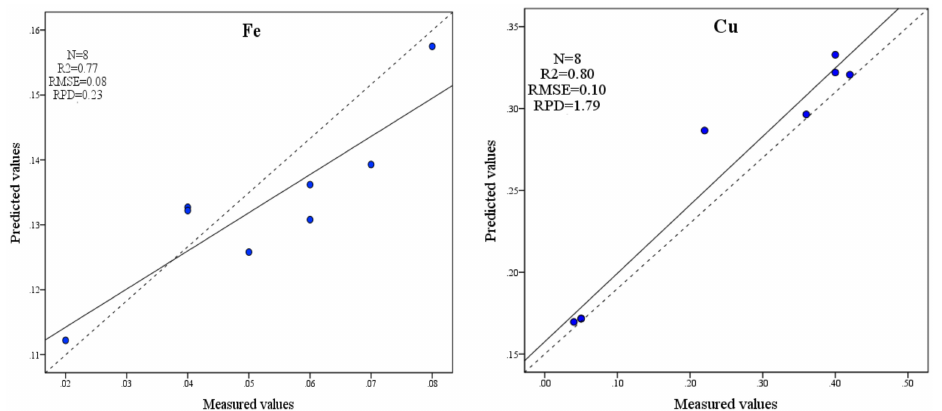
Figure 9. Accuracy test of BP neural network regression